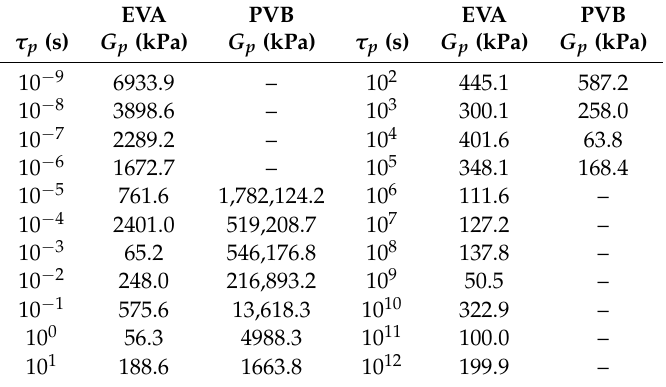
Table 6. Prony series for the generalised Maxwell model with the relaxation times τ p and corresponding shear moduli G p for the reference temperature T 0 = 20 ◦ C and the long-term moduli G ∞ = 682.18 kPa for EVALAM 80-120 (EVA) and G ∞ = 232.26 kPa for TROSIFOL BG R20 (PVB),